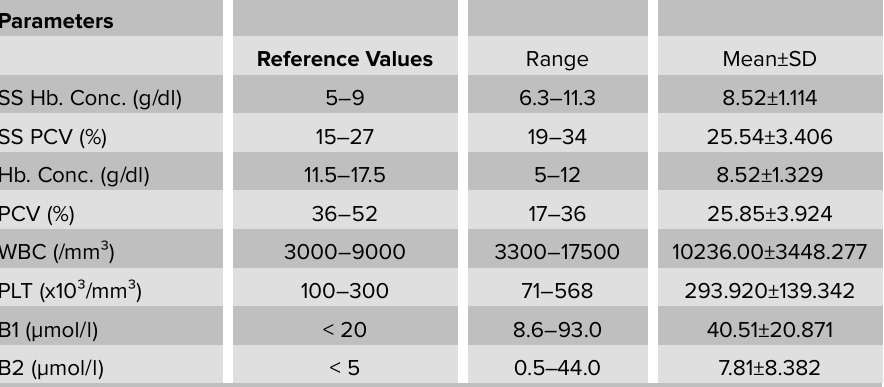
Table 3: Hematologic and biochemical investigation results.